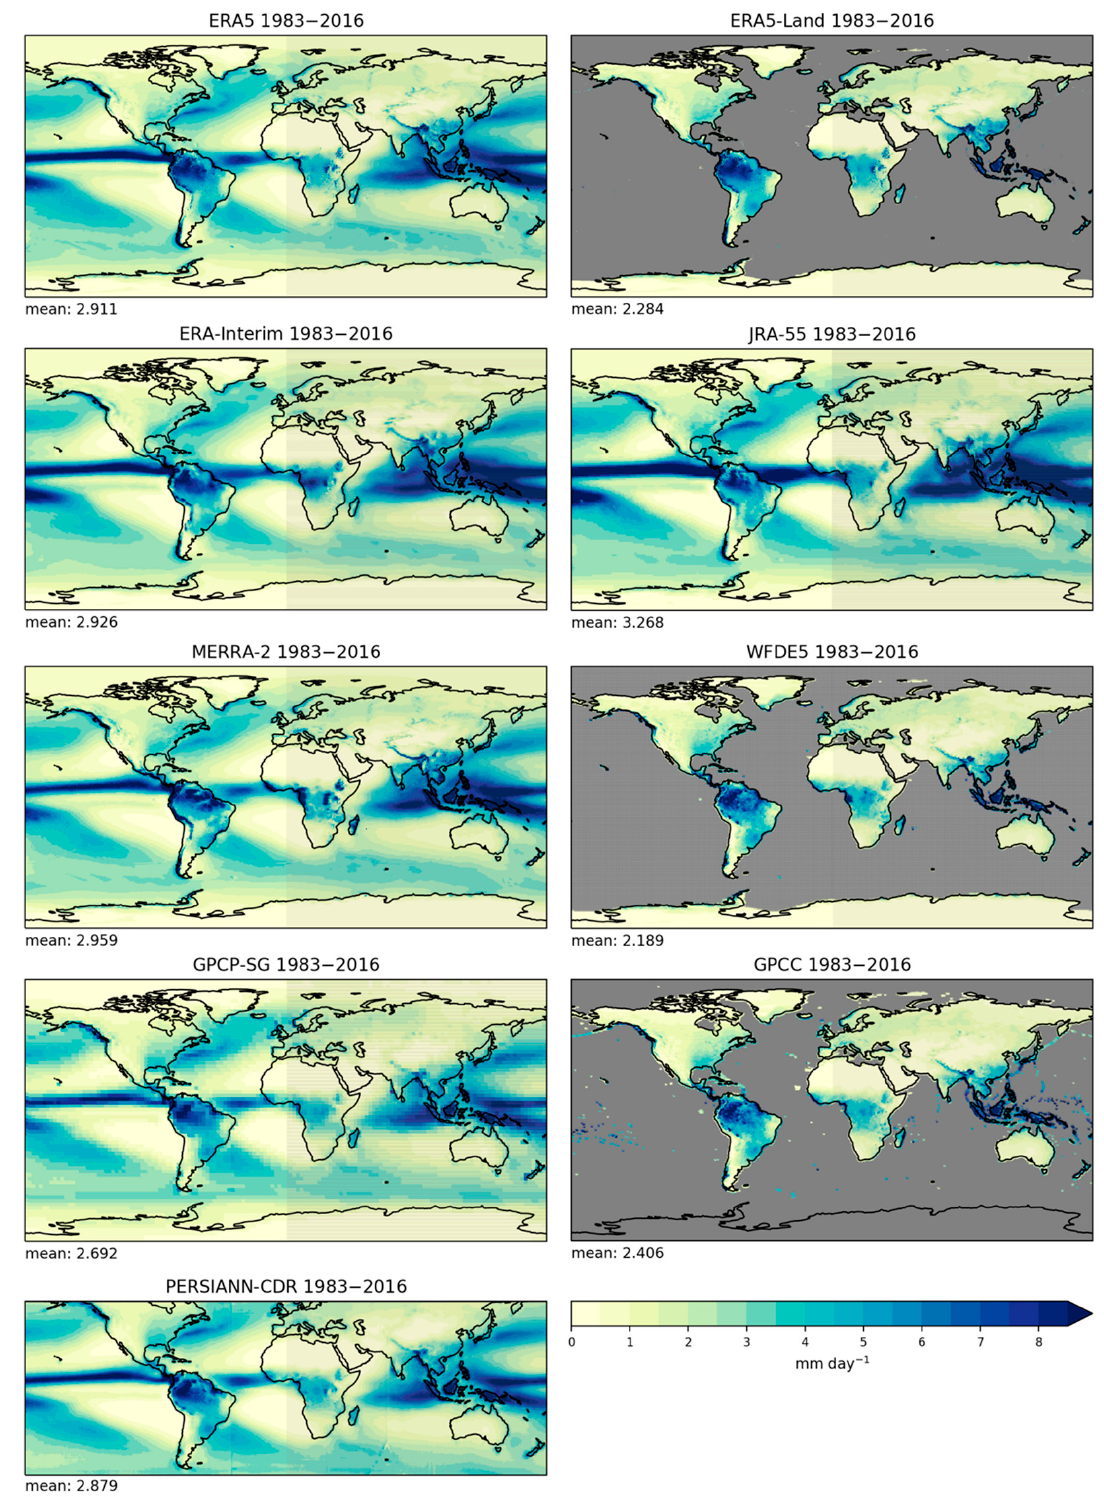
Figure 2. Global multi-year annual mean precipitation rates averaged over the time period 1983–2016 from the nine global datasets covering this time period. Data are shown in their native spatial resolution.